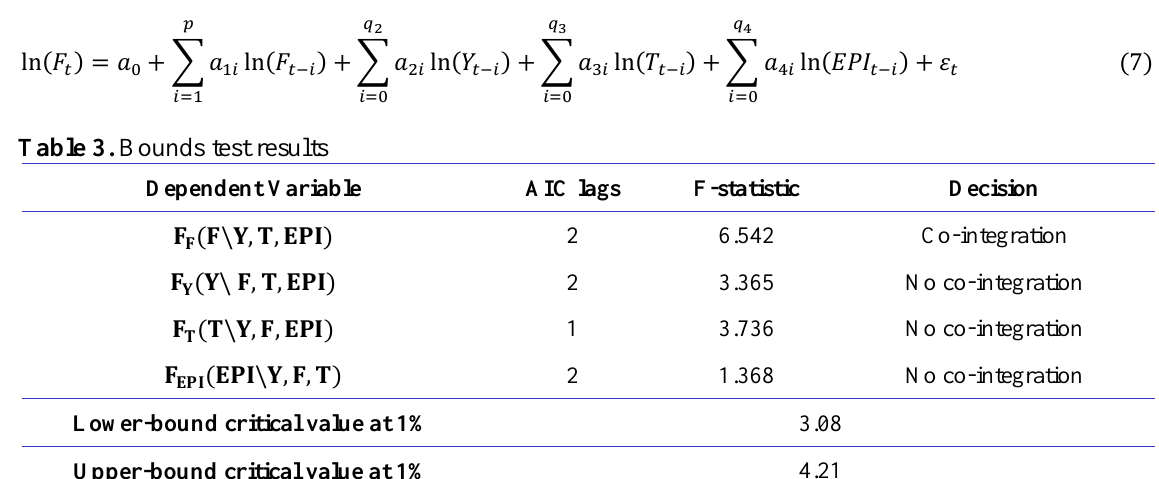
Table 3. Bounds test